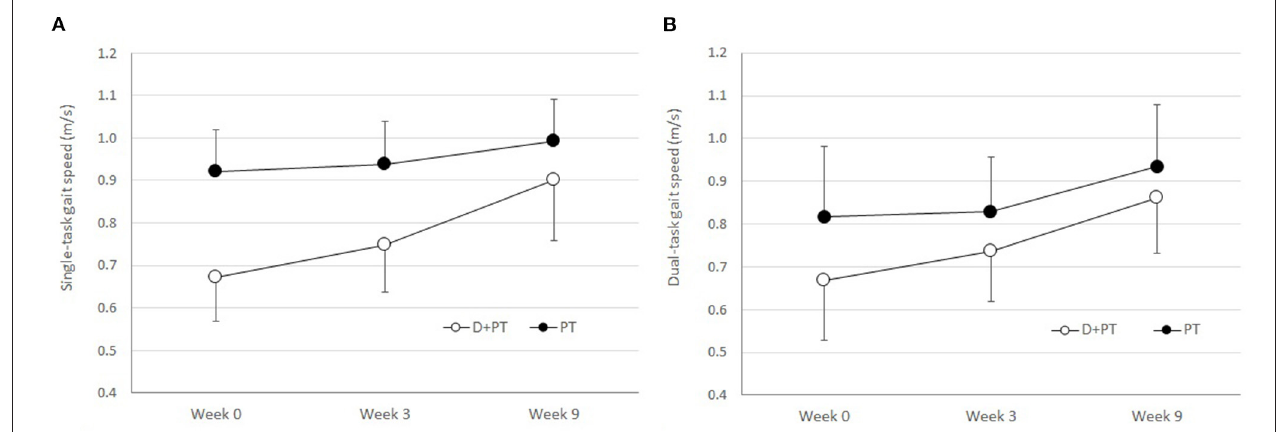
FIGURE 1 | (A) Single-task gait speed and (B) dual-task gait speed by group and time point. Week 0–3 represents dalfampridine only for D + PT group and no-treatment phase for PT group. Week 3–9 represents the physical therapy phase with or without dalfampridine. D + PT denotes dalfampridine plus physical therapy; PT denotes physical therapy without dalfampridine. Error bars are